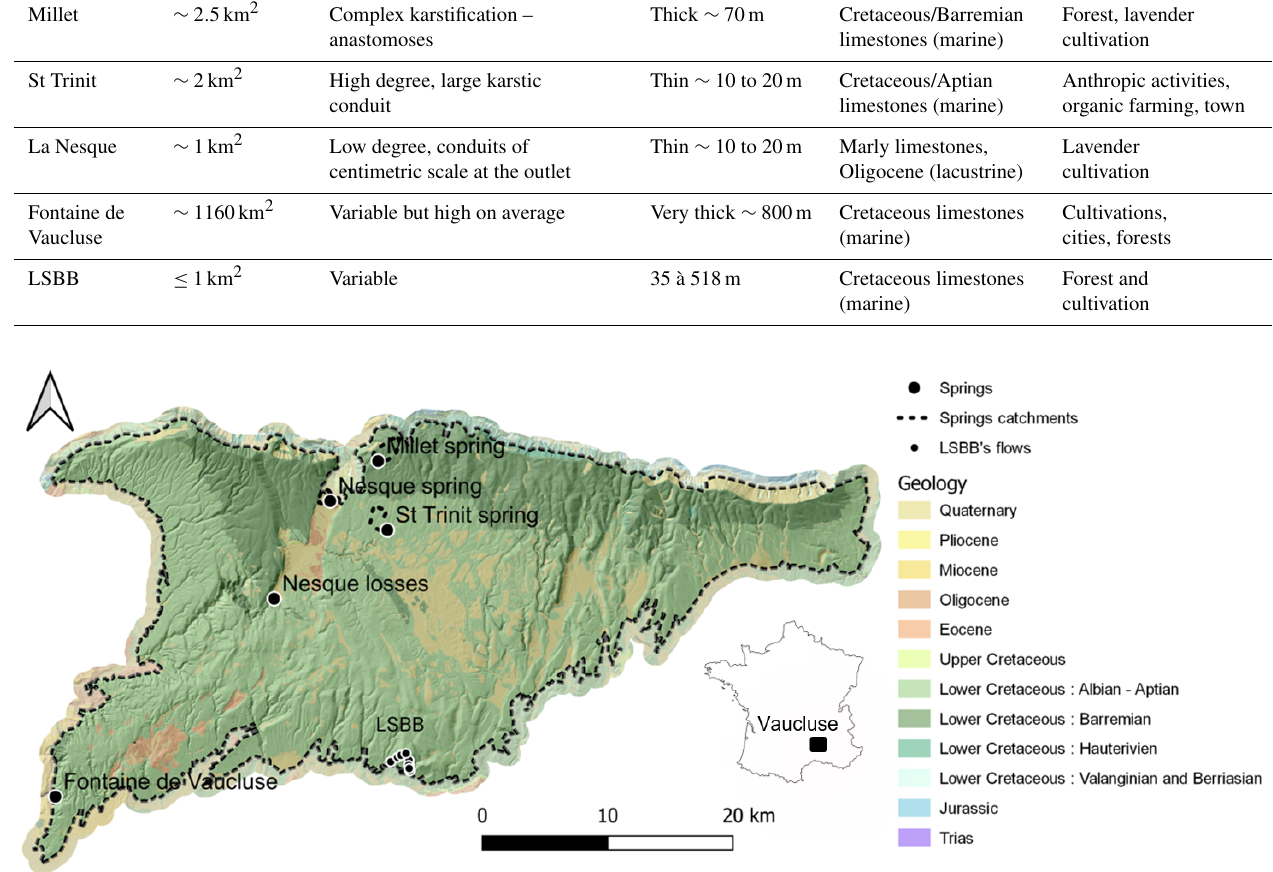
Figure 1. Location of monitored flow points on a 1 : 50000 geological map (BD-CHARM) from BRGM and spring catchment delineation (based on geology and mass balance for Millet, St Trinit, and Nesque springs; from Ollivier (2019) for Fontaine de Vaucluse).